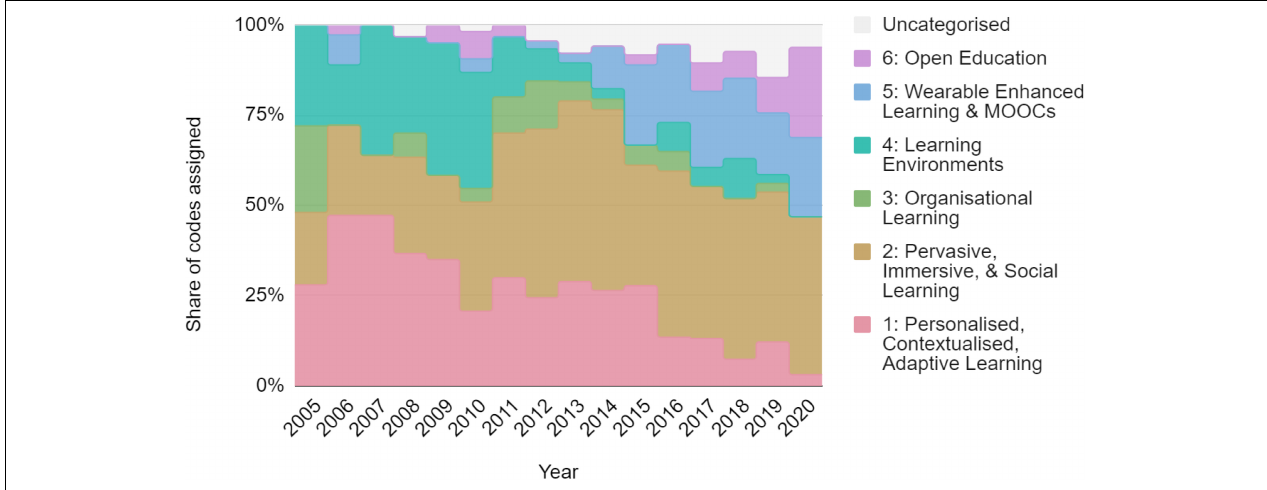
FIGURE 4 | Shift of session topics over the years (Uncategorized comprises those sessions that were coded with codes that appeared overall only up to three